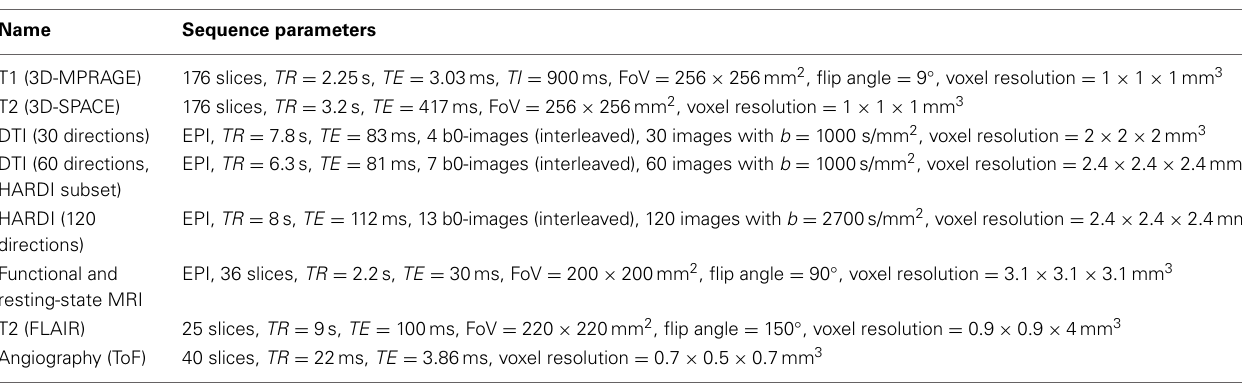
Table 1 | Overview over the MRI sequences used in 1000BRAINS with relevant sequence